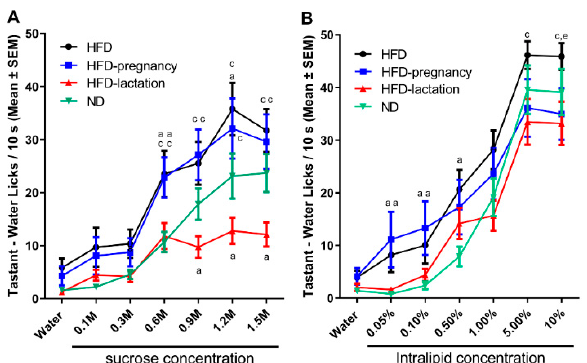
Figure 4. Short access taste responses to palatable sucrose and Intralipid solutions. Mean number of licks / 10 s made for water and increasing concentrations of palatable solutions during taste testing at age of 10–11 weeks. Sucrose testing ( A ), and Intralipid testing ( B ). Group representations for both graphs: black lines and symbols: HFD o ff spring ( n = 9); light blue lines and symbols: HFD-pregnancy o ff spring ( n = 9); red lines and symbols: HFD-lactation o ff spring ( n = 7); and green lines and symbols: ND group of o ff spring ( n = 9). Statistical symbols represent post hoc comparisons between individual diet groups as follows: a p < 0.05 compared with ND; c p < 0.05 compared with HFD-lactation, e p < 0.05 comparing HFD with HFD-pregnancy. Data expressed as mean ± SEM. For more details and statistics, see